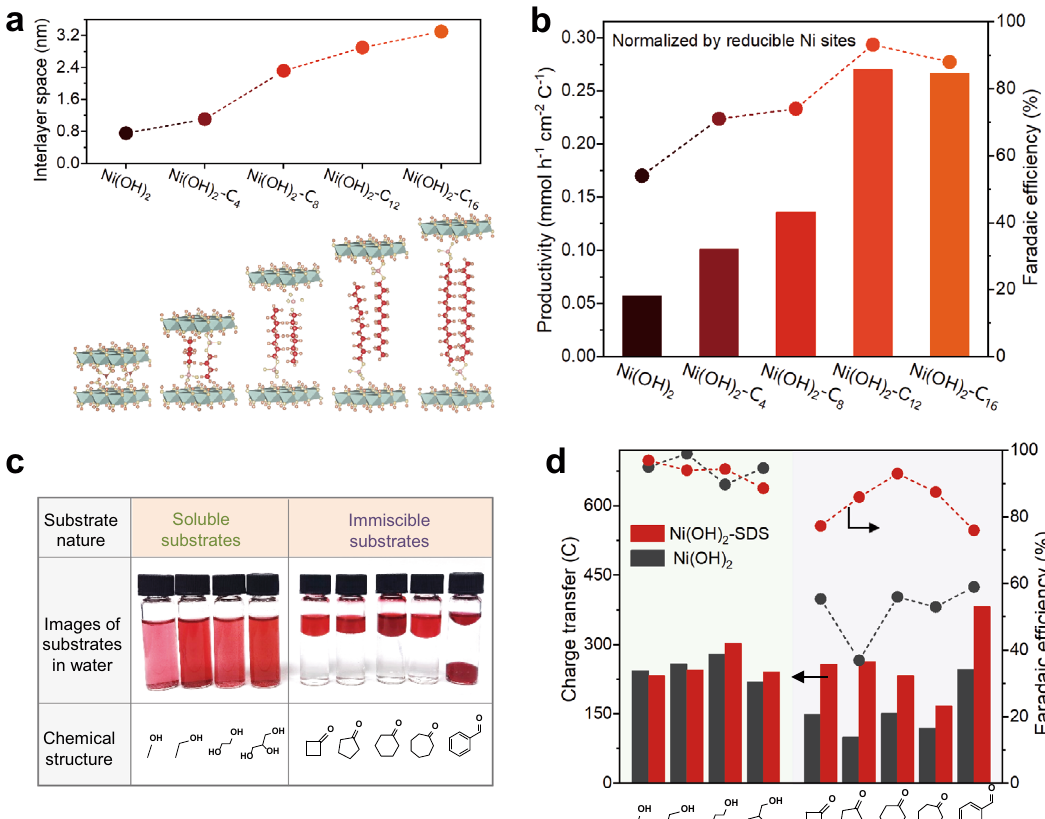
Fig. 7 | Universality of the ligand modi fi cation strategy. a Interlayer space of different Ni(OH) 2 -C n samples that detected by XRD. b Reducible Ni sites- normalized productivity and FE of adipicacid over differentNi(OH) 2 -C n samplesin 0.5M KOH with 0.4M cyclohexanone at 1.5V vs RHE (stirring rate=800rpm).